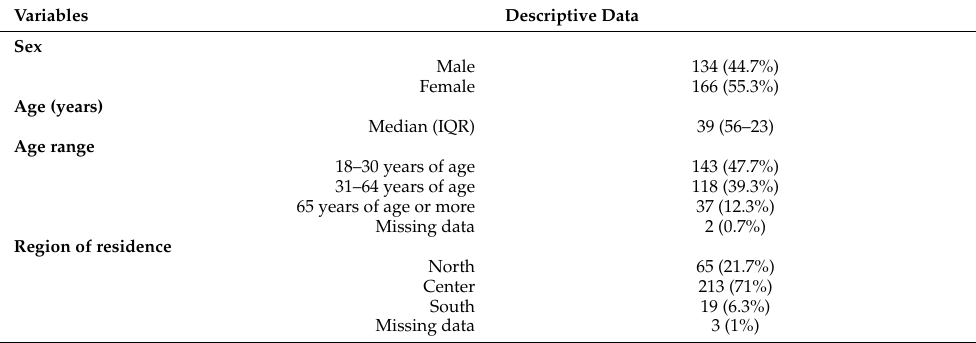
Table 1. Socio-demographic characteristics of the sample ( n = 300).